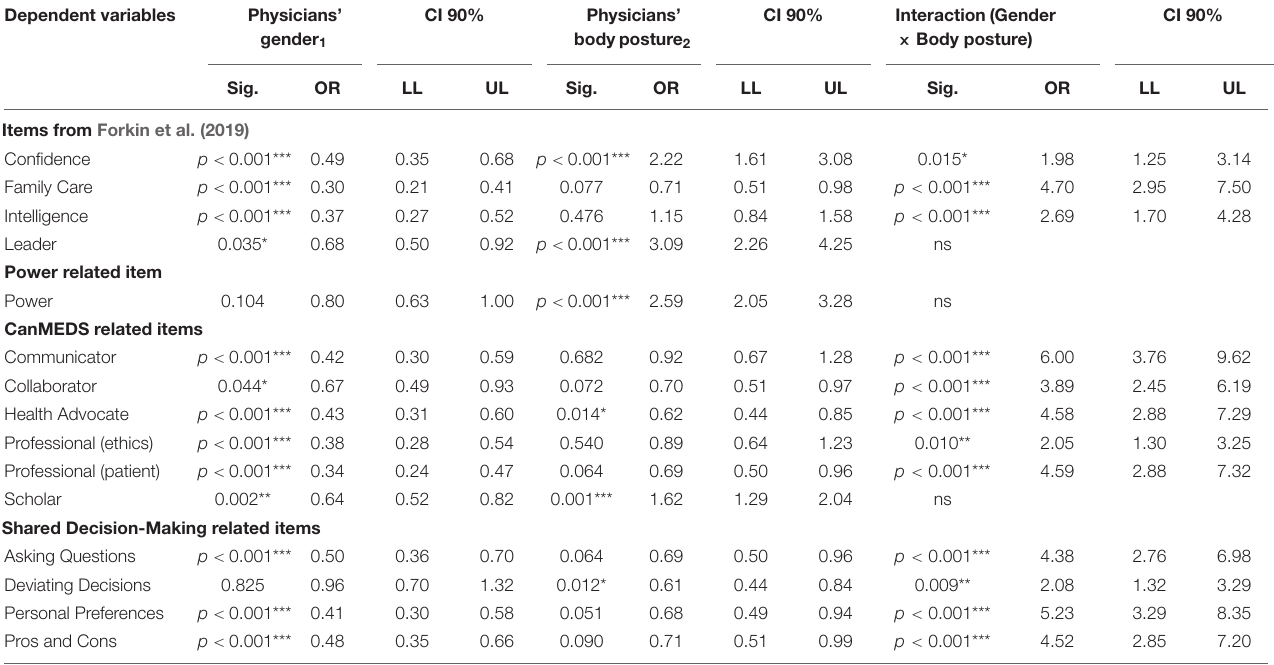
TABLE 3 | Results of logistic functions, regressing physicians’ posture, gender and posture × gender on the dependent variables. Dependent variables Physicians’ CI 90% Physicians’ CI 90% Interaction(Gender CI 90% × Body posture) gender 1 bodyposture 2